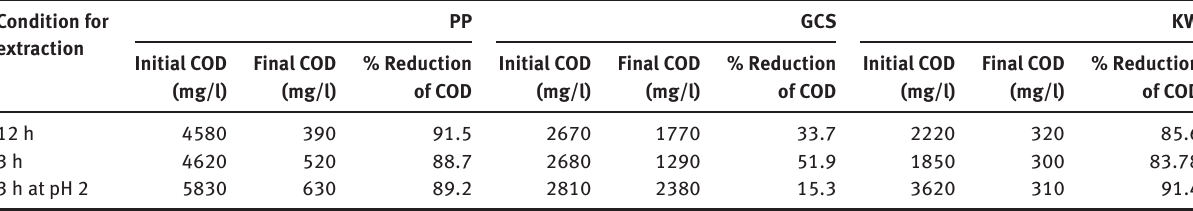
Table 1: Change in COD before and after adsorption of Cr(VI) from 50 mg/l solution. Condition for